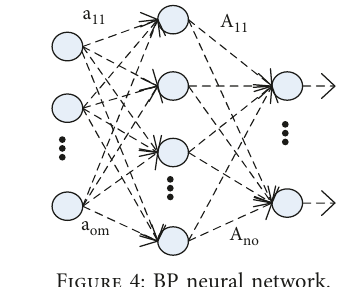
Figure 4: BP neural